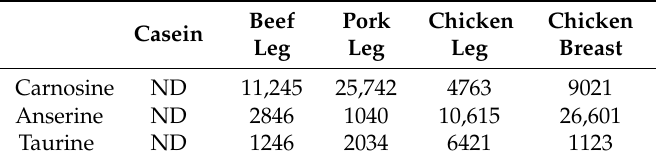
Table 6. Carnosine, anserine, and taurine levels in experimental protein sources.